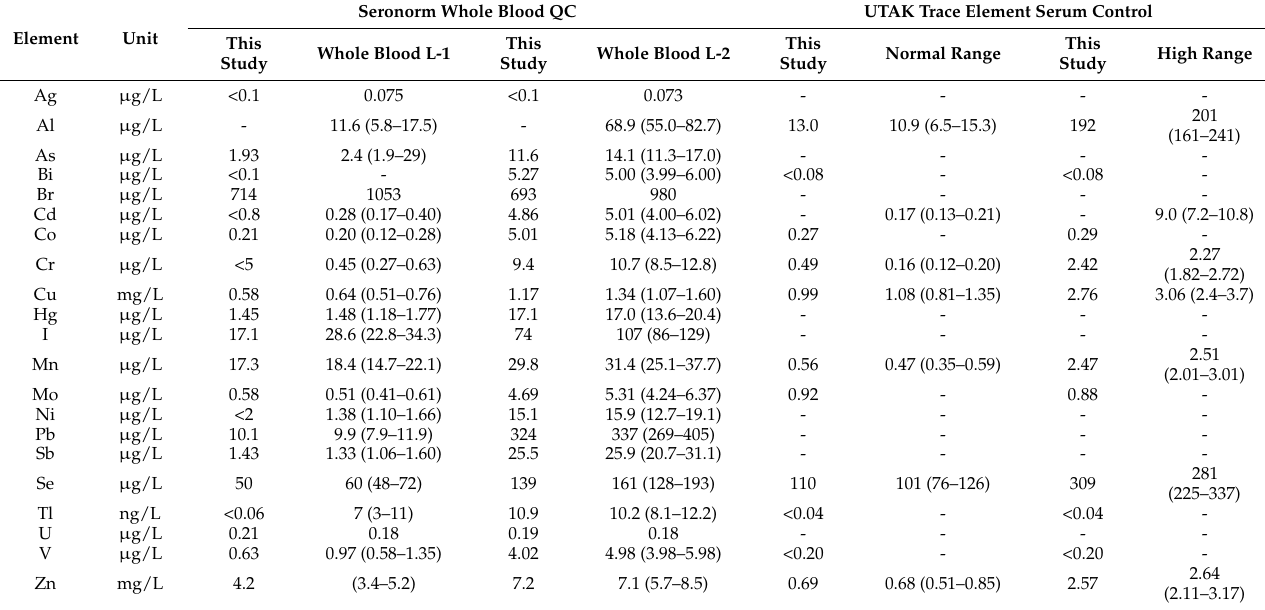
Table 3. Mean levels of trace elements in the Certified Reference Materials of quality control for whole blood and plasma.